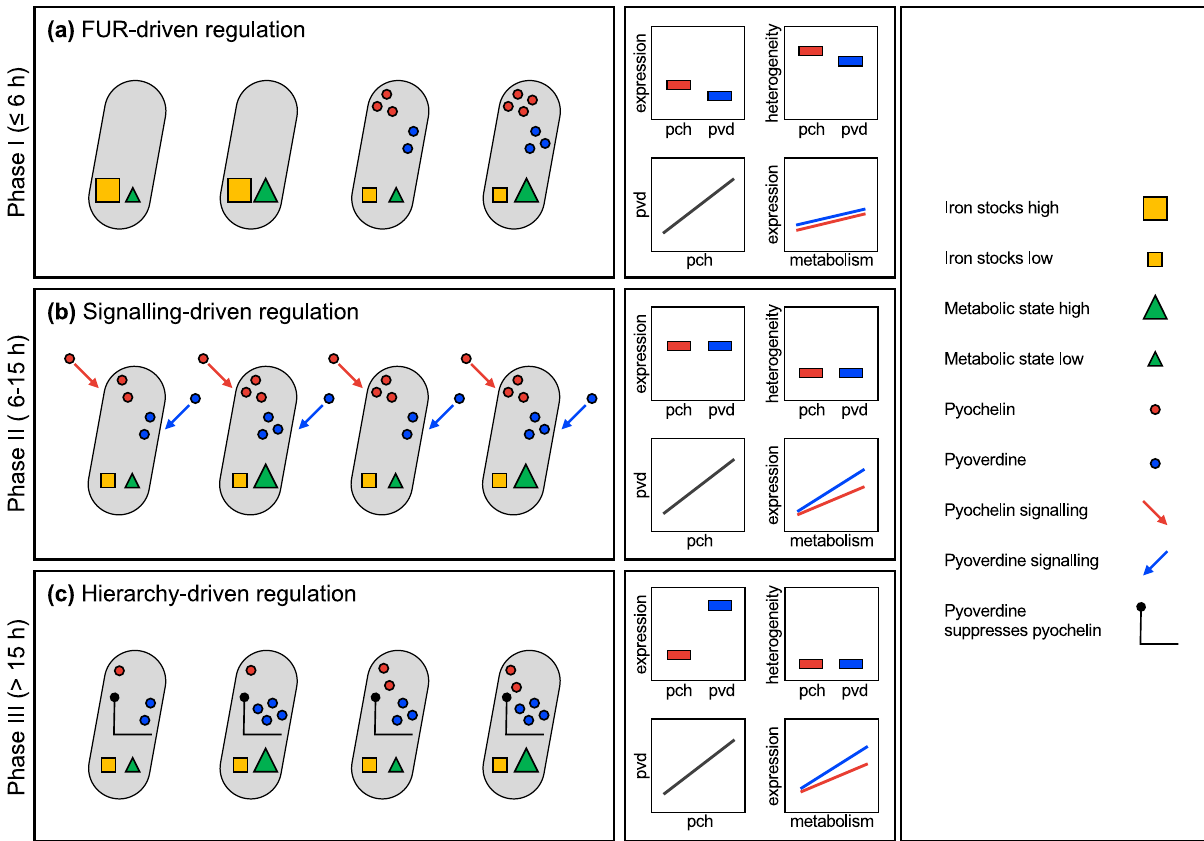
Fig. 6 A three-phase model of how regulatory elements, internal iron stocks, and the metabolic state of cells can explain decision-making processes and the chronobiological cycle of siderophore gene expression in growing populations of P. aeruginosa . a Phase I (up to 6 h) is driven by Fur (ferric uptake regulator) and variation in internal iron-stocks across cells. Cells with low stocks start to express and produce pyochelin and pyoverdine independent of their metabolic state. This induces high gene expression heterogeneity (including bimodality) across cells and strong positive correlations between pyochelin and pyoverdine expression. b Phase II (between 6 and 15 h) is driven by signalling-mediated regulation and variation in the metabolic state. Siderophore-mediated signalling leads to homogenized and increased levels of gene expression. Residual variation across cells is largely explained by metabolic state differences. c Phase III (>15 h) is driven by hierarchy-driven regulation, inducing a shift from pyochelin to pyoverdine gene expression. Residual variation across cells is still explained by metabolic state differences, and more so for pyoverdine than for